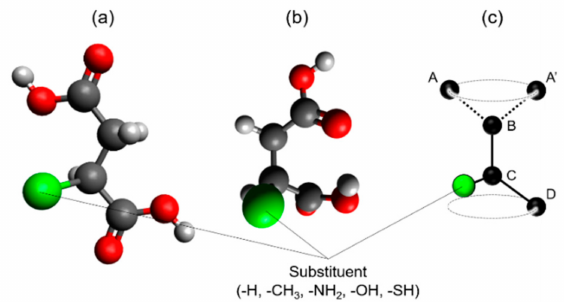
Figure 4. Schematic steric structures of succinic acid derivatives: ( a ) Z-type and ( b ) C-type. ( c ) Carbon atom arrangements of A-B-C-D and A’-B-C-D indicate Z-type and C-type succinic acid derivatives, respectively. The carbon atoms A, A’, and D belong to the carboxyl